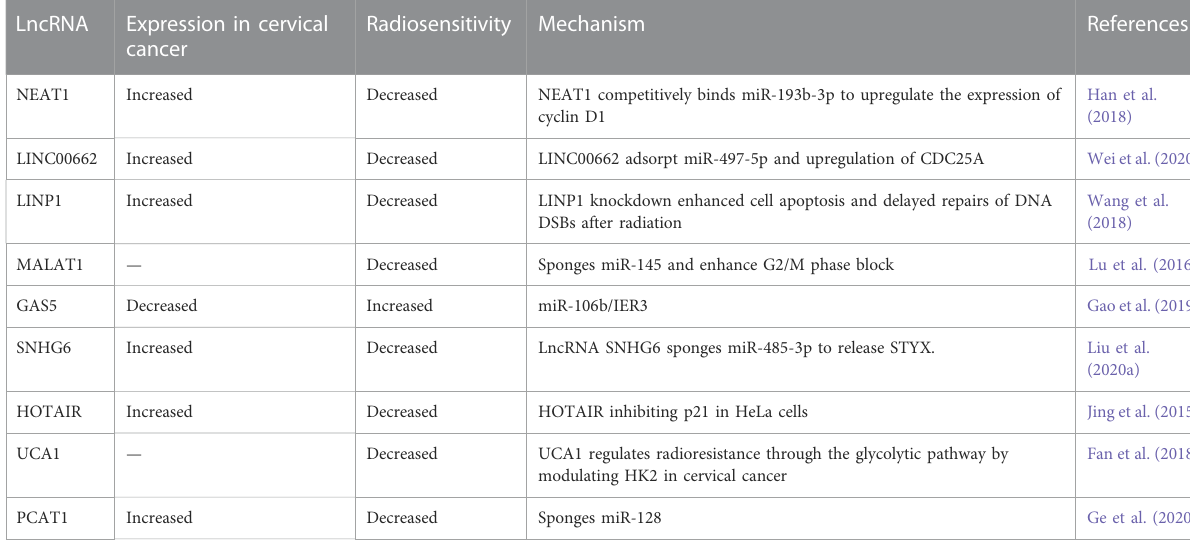
TABLE 1 LncRNAs and radiotherapy in cervical cancer.